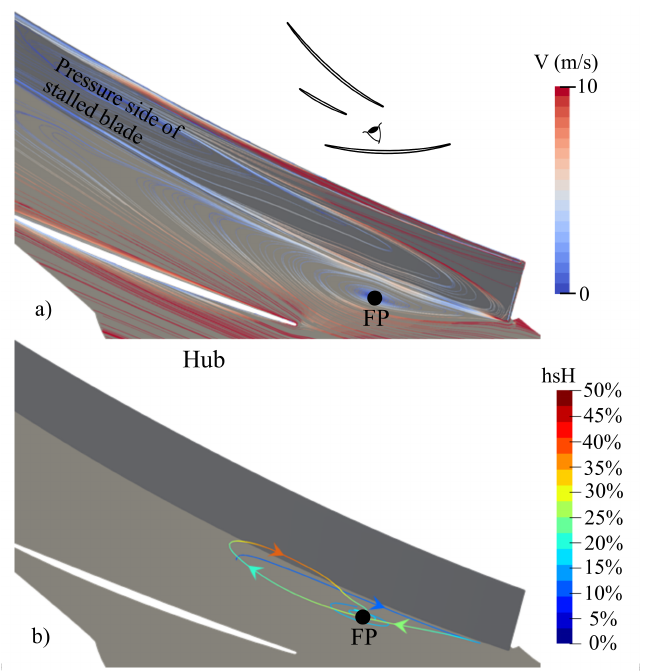
Figure 14. Topological structure at the corner pressure side of the stalled blade/hub in the free channel at OP2: ( a ) friction lines colored by the velocity and ( b ) 3D streamlines generated from the FP and colored by the span height.